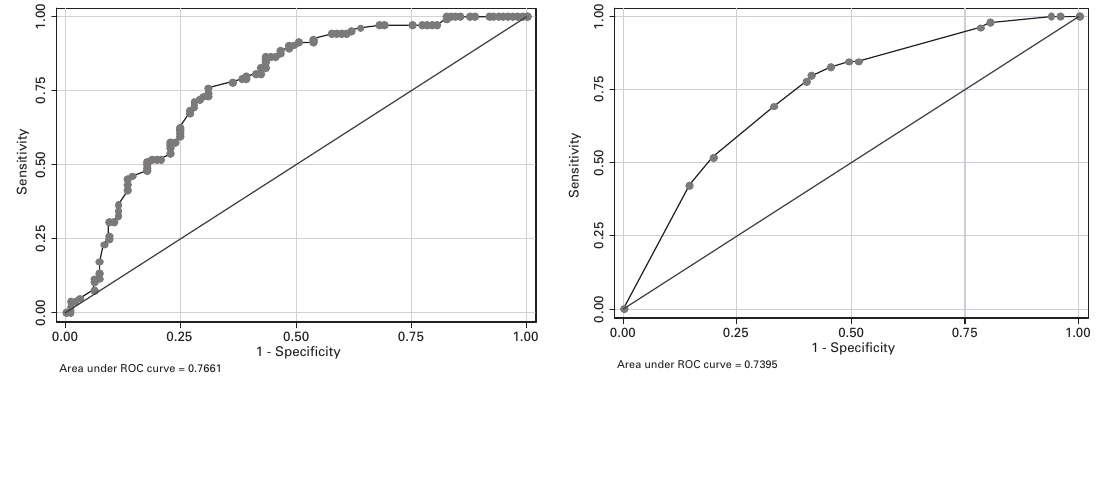
ROC curve, model with the four variables: time-period of consultation (weeks 49–50, 51–5), duration of symptoms before first medical attendance (<48h, >48h), temperature >37.8 °C and